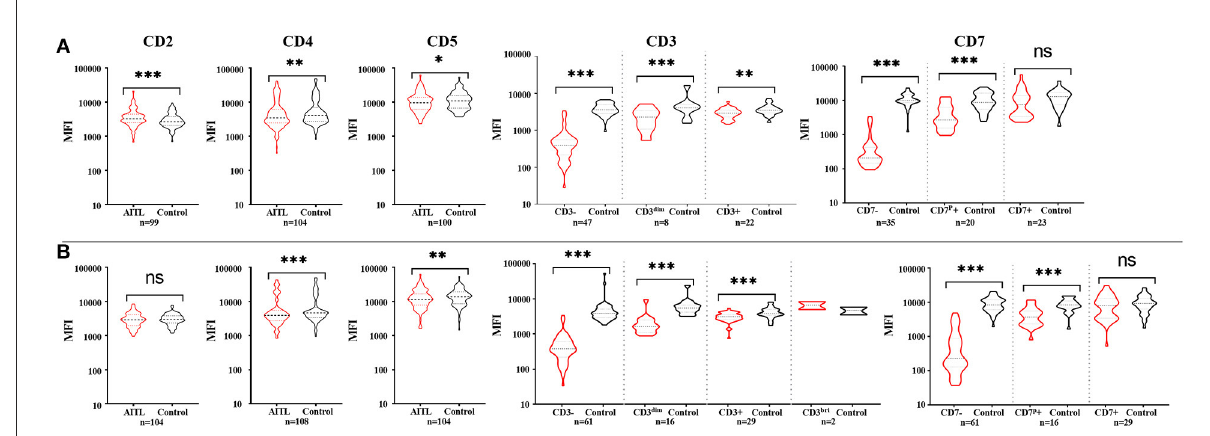
FIGURE1 The expression features of pan-T cell antigens of AITL patients in tissue (A) and bone marrow (B) . (A) Compared with the corresponding non-neoplastic CD4 + T cells in AITL, neoplastic T cells had bright CD2 expression and diminished CD3, CD4, and CD5 expression. CD7 mean fluorescent intensity (MFI) had no significant difference between CD7 + neoplastic T cells and normal CD4 + T cells. (B) In bone marrow samples, neoplastic T cells had obviously diminished CD3, CD4, and CD5 expression, and there were no significant difference of CD2 expression between neoplastic T cells and normal CD4 + T cells. CD7 mean fluorescent intensity (MFI) had no significant difference between CD7-positive neoplastic T cells and normal CD4 + T cells. * p < 0.05, ** p < 0.01, *** p <